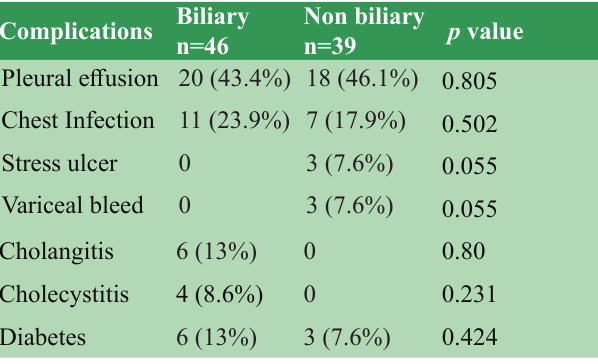
Table 7: Incidence of other complications in Biliary and Non biliary pancreatitis Biliary Complications n=46